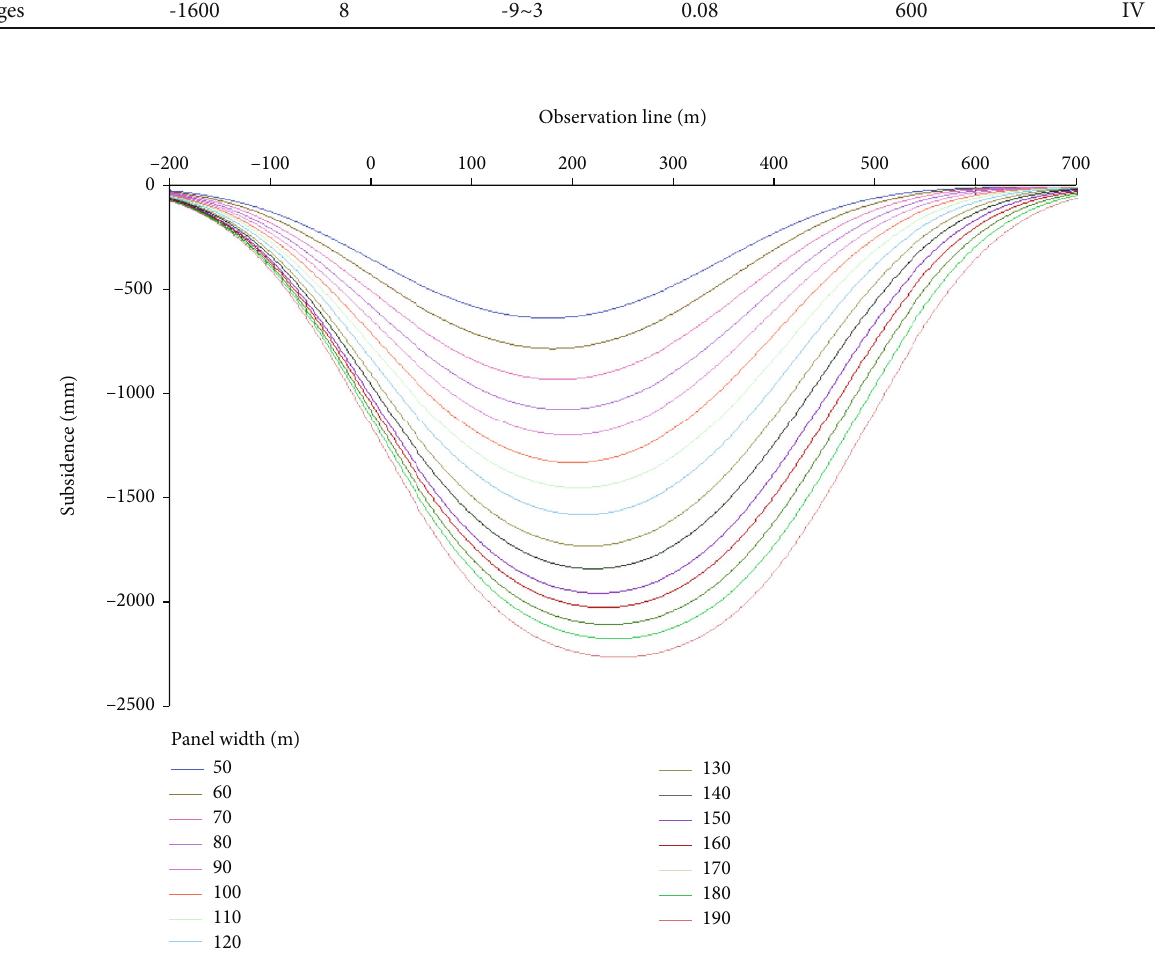
Figure 6: The surface subsidence prediction for di ff erent panel widths (without